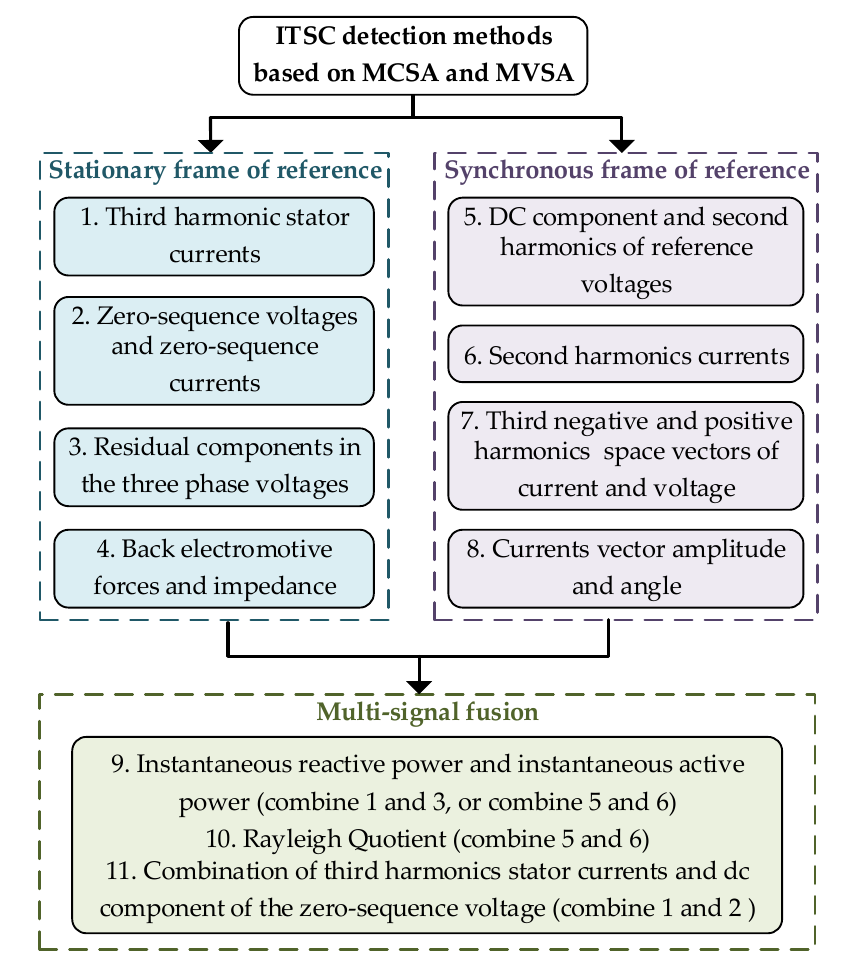
Figure 1. Classification and connection of detection methods.